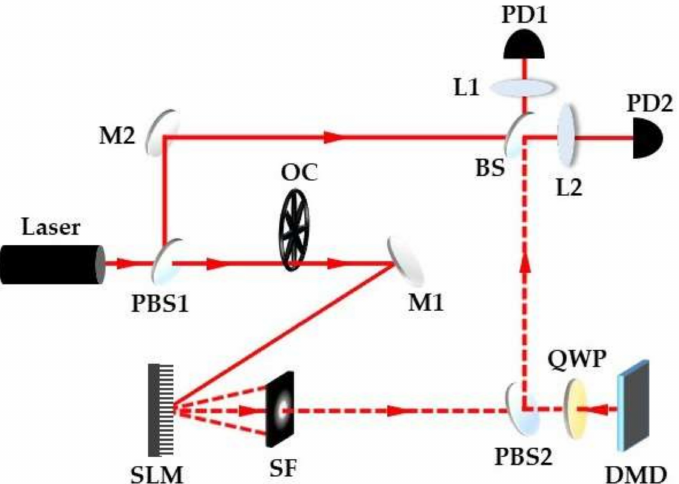
Figure 5. Experimental setup to measure the rotation speed and direction of a simulated particle based on RDE. PBS1~2: Polarizing beam splitter, M1~2: Mirror, SLM: Spatial light modulator, OC: Optical chopper, SF: Spatial filter, BS: Beam splitter, L1~2: Lens, QWP: Quarter-wave plate, PD1~2: Photoelectric detector, DMD: Digital micromirror